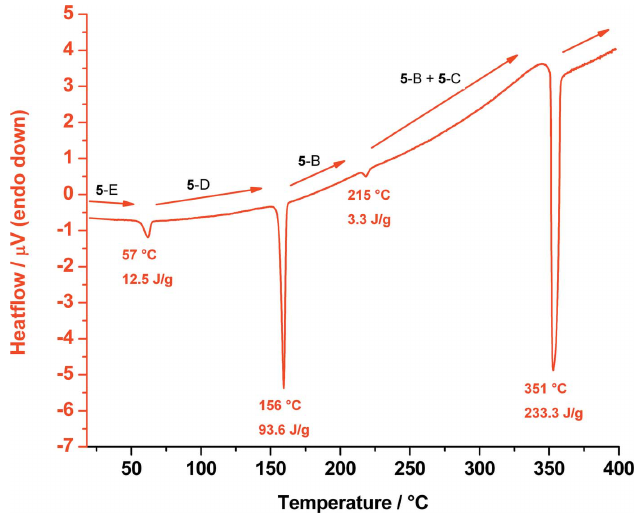
Figure 11 DSC trace of cis -inositol ( 5 ) measured from 20 up to 400 (cid:2) C showing the phase transition of polymorph 5 -E back to 5 -D at 57 (cid:2) C, 5 -D back to 5 -B at 156 (cid:2) C and 5 -B to 5 -C at 215 (cid:2) C until melting/decomposition of 5 -C at 351 (cid:2) C.